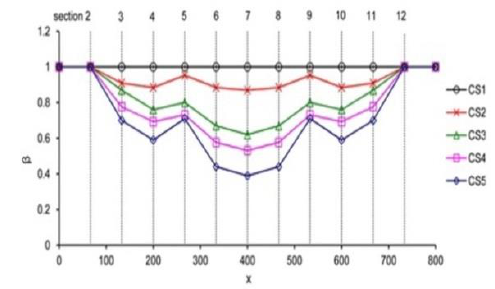
Figure 21. β function as an indicator of severity and location of damage in model structure